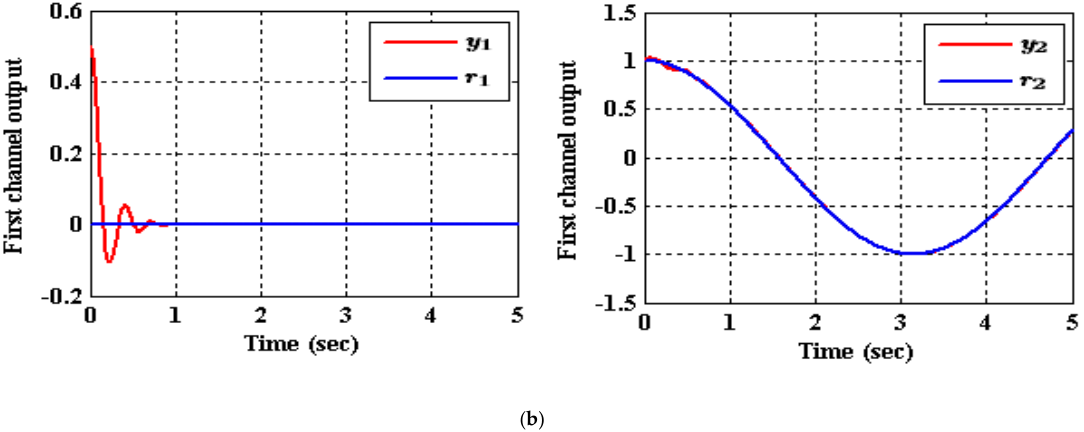
Figure 9. The output tracking of Equation (42) due to reference inputs r 1 and r 2 using a decoupled control scheme with IADRC, ( a ) ( r 1 , r 2 ) = ( sin ( t ) ,0 ) ; ( b ) ( r 1 , r 2 ) = ( 0, cos ( t )) [23].